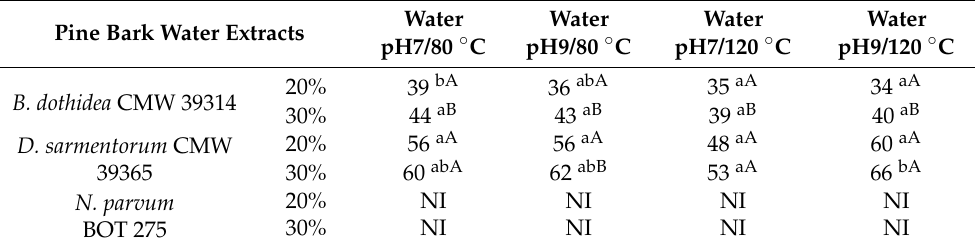
Table 1. Mycelial growth inhibition (%) by pine bark water